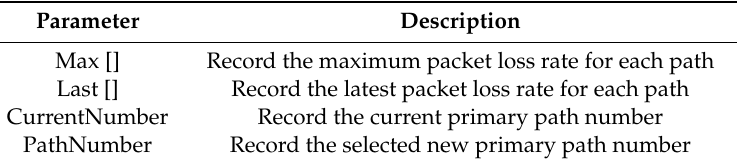
Table 2. Parameter descriptions of the MS-SCTP